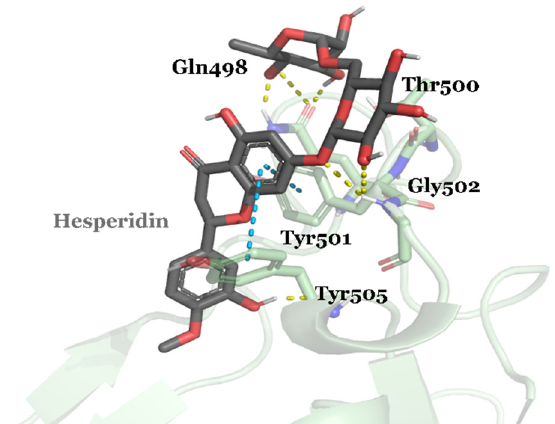
Figure 6. A representative snapshot of the docking pose of hesperidin with the Alpha variant. B.1.1.7 (Alpha’s) residues are colored according to the atom type of the interacting amino acid residues (protein’s carbon, pale green; oxygen, red; nitrogen, blue). Dash lines represent the protein–ligand interactions: hydrogen bond interactions are colored in yellow; π - π interactions are colored in blue.